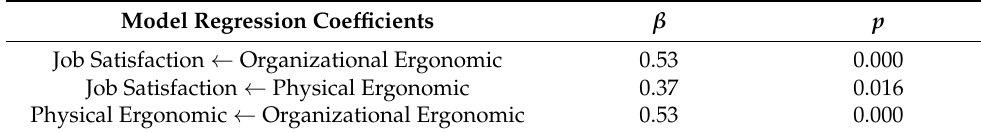
Table 13. Model regression